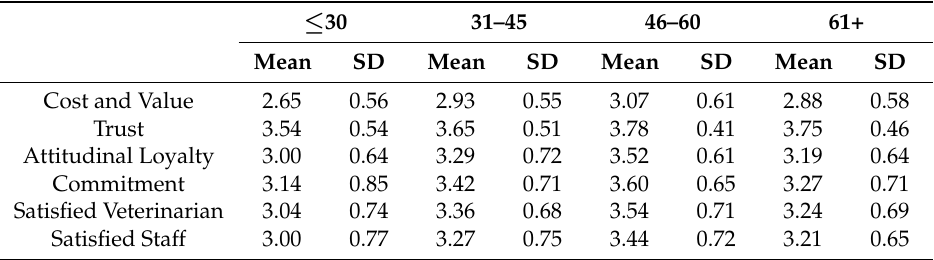
Table 3. Mean differences by